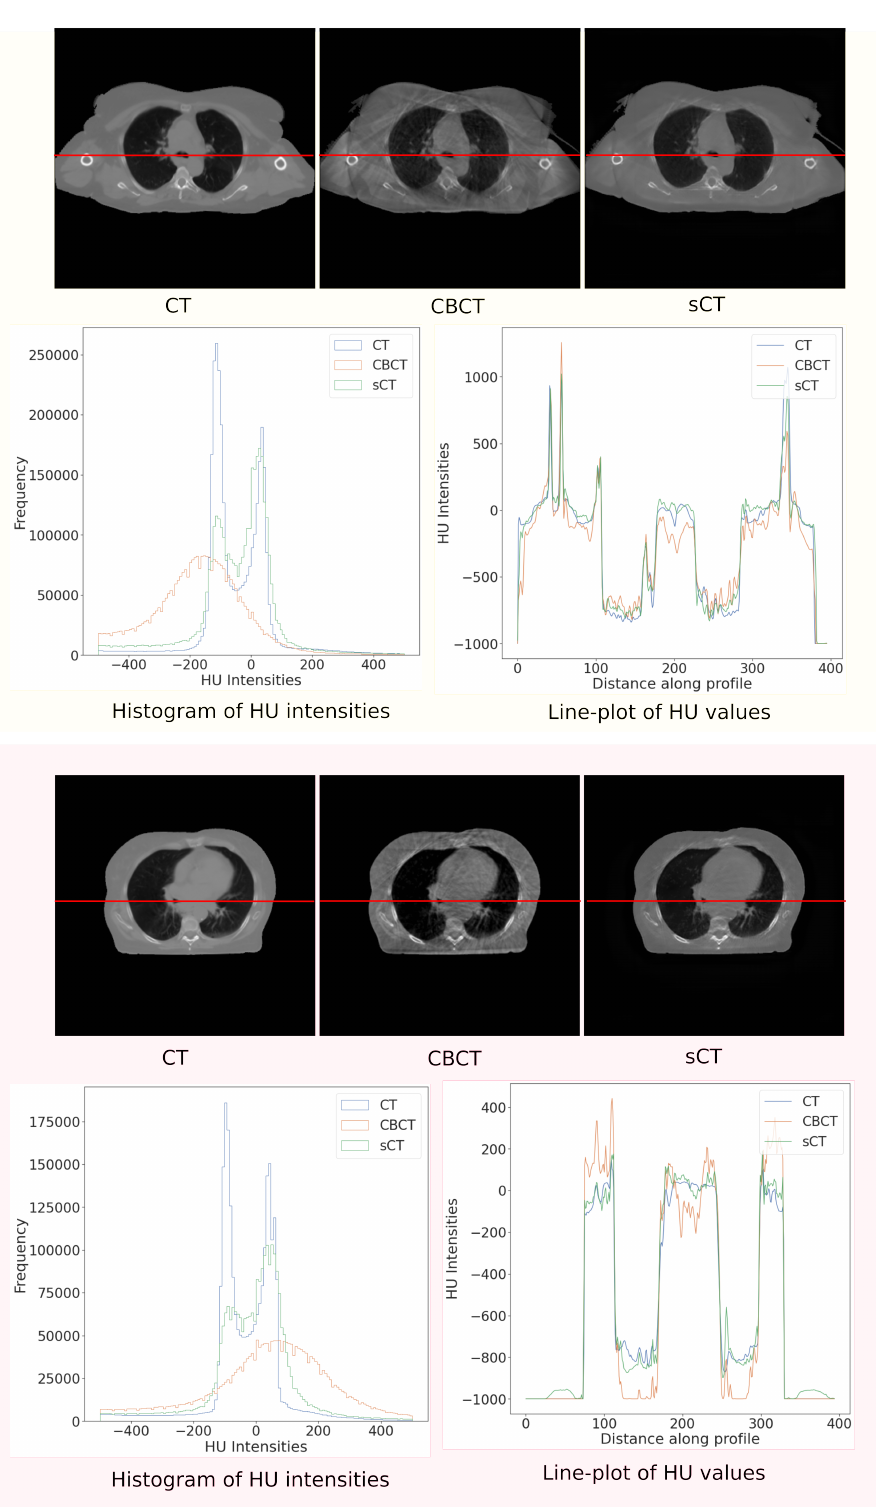
Figure 6. Histogram of HU intensities and line profiles shown for CT, CBCT, and sCT on two patients chosen randomly from the test set. The line chosen for profiling is highlighted by a red line passing the axial view of the